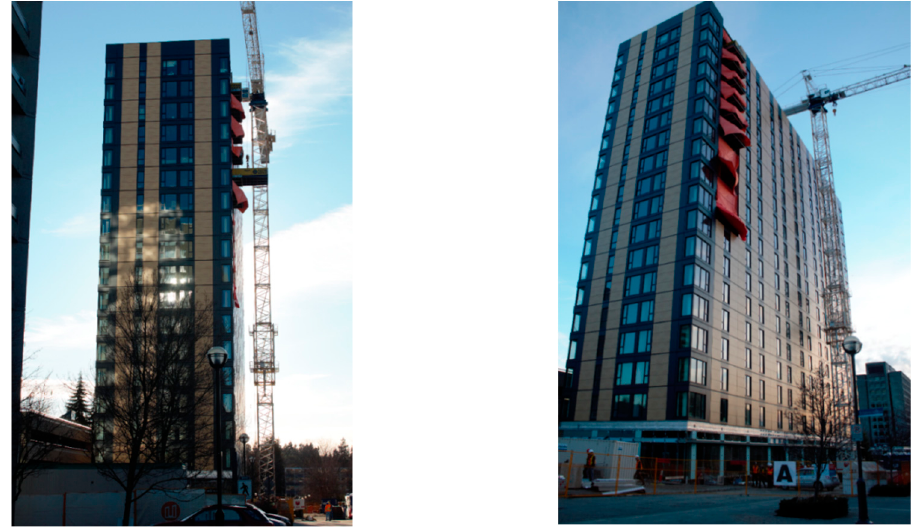
Figure 3. Tall hybrid timber building Brock Commons, Vancouver, Canada.